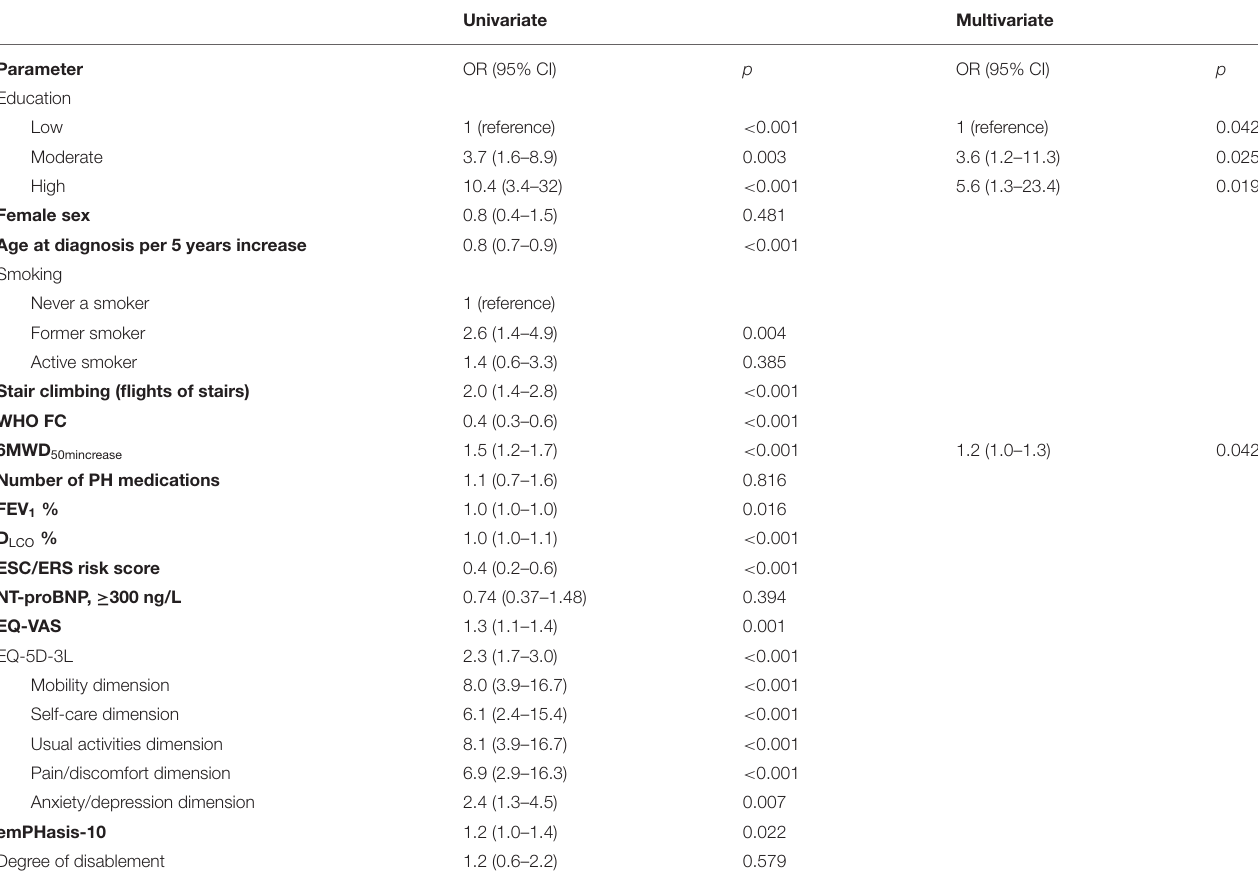
TABLE 3 | Influencing factors on employment in pulmonary arterial hypertension